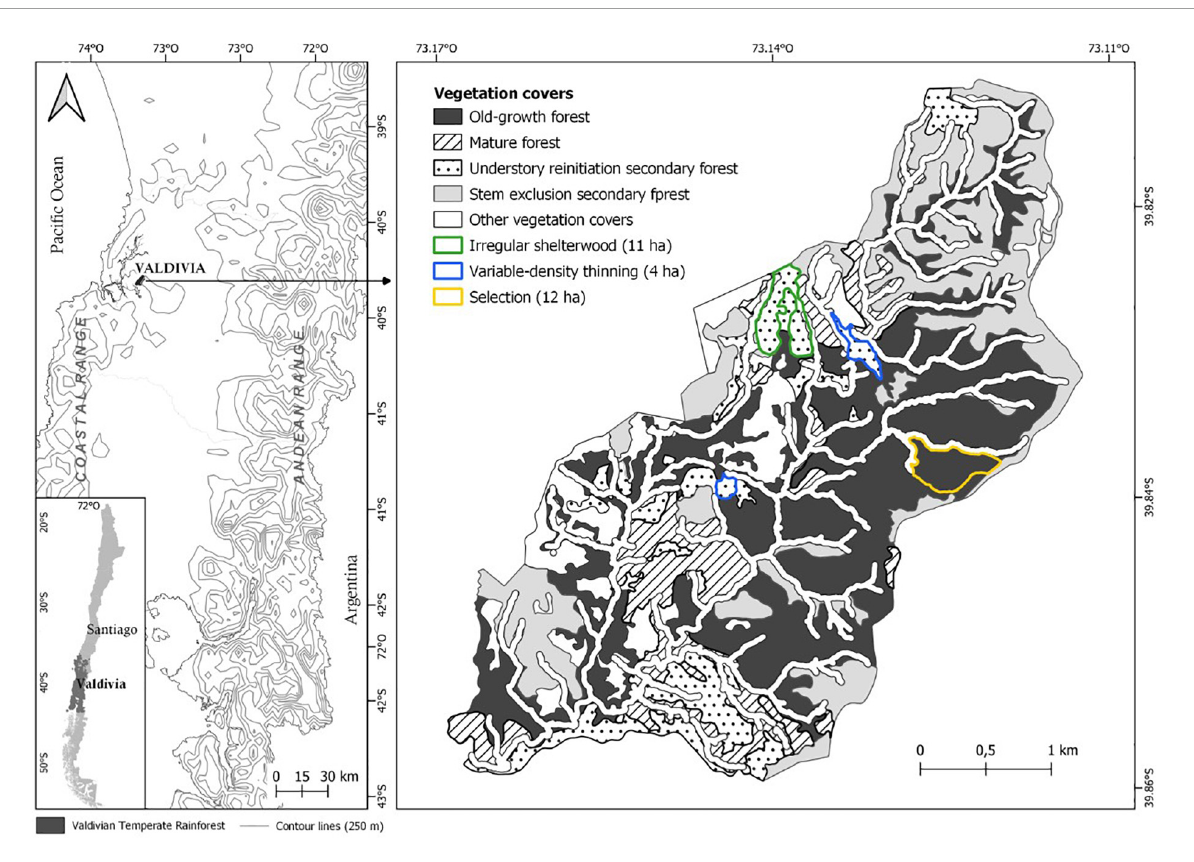
FIGURE1 Location of the Llancahue experimental forest and the studied stands within